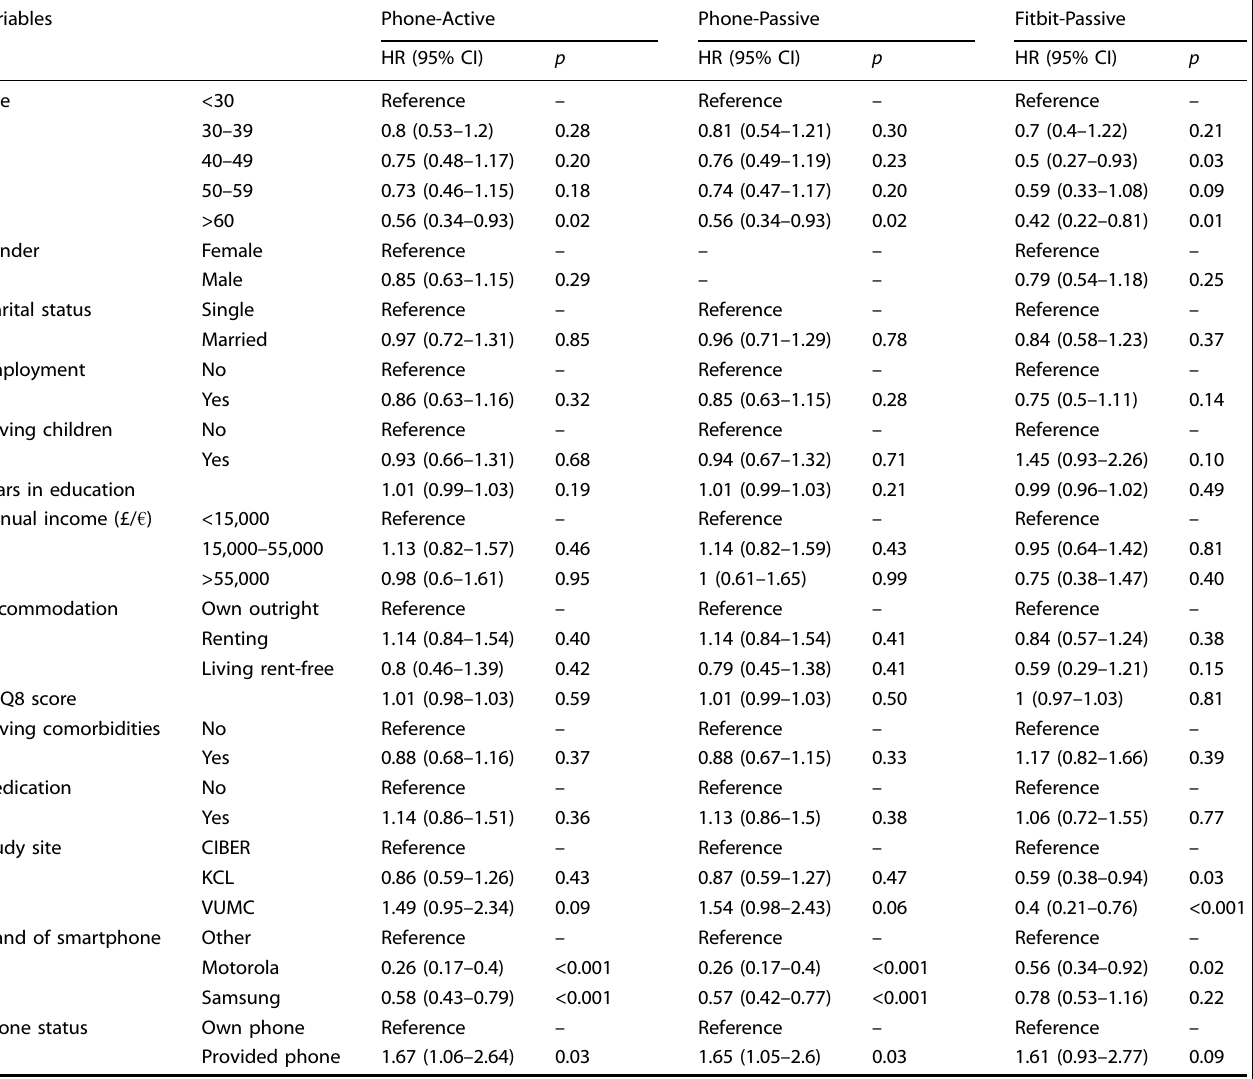
Table 2. The estimates and 95% con fi dence intervals of hazard ratio (HR) of variables in the Cox models for assessing the impact of multiple variables of interest on the participant retention time in the fi rst 43 weeks of the study for Phone-Active, Phone-Passive, and Fitbit-Passive data streams,